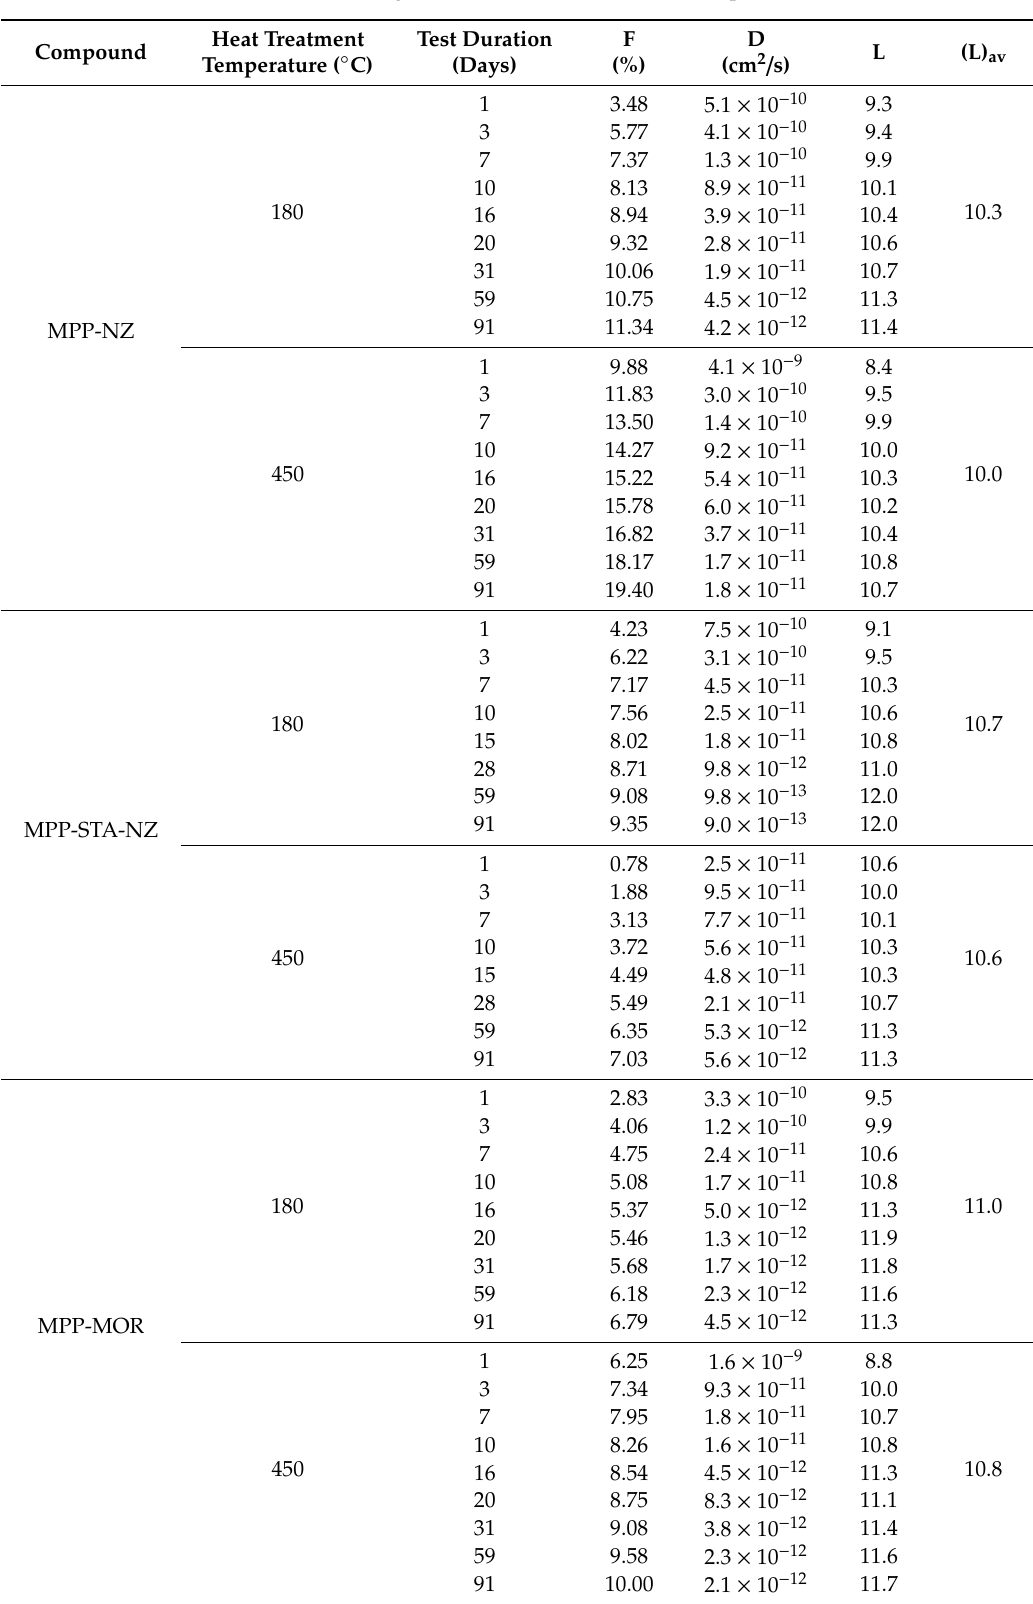
Table 4. Leaching data of 137 Cs from the MPP